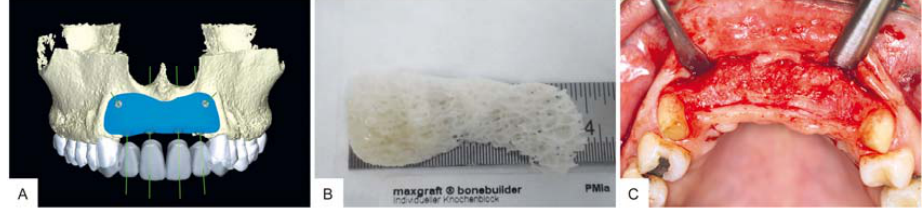
Figure 2. CAD/CAM block design and real bone allograft. ( A ) Virtual three ‐ dimensional reconstruction of the defect and bone block design (blue); ( B ) Customized CAD/CAM bone block; ( C ) Grafted area showed sufficient bone volume and vital tissue for implant placement six months after GBR procedure.